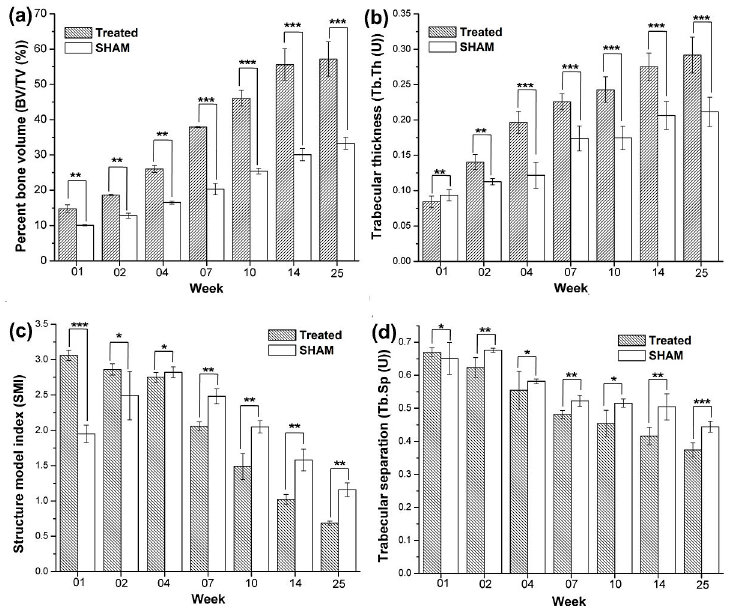
Figure 4. µCT analysis of (a) Percentage of Bone volume/Tissue volume, (b) Trabecular thickness, (c) Structural model index and, (d) Trabecular separation in n-HA/gel/CMC treated and SHAM-operated groups.